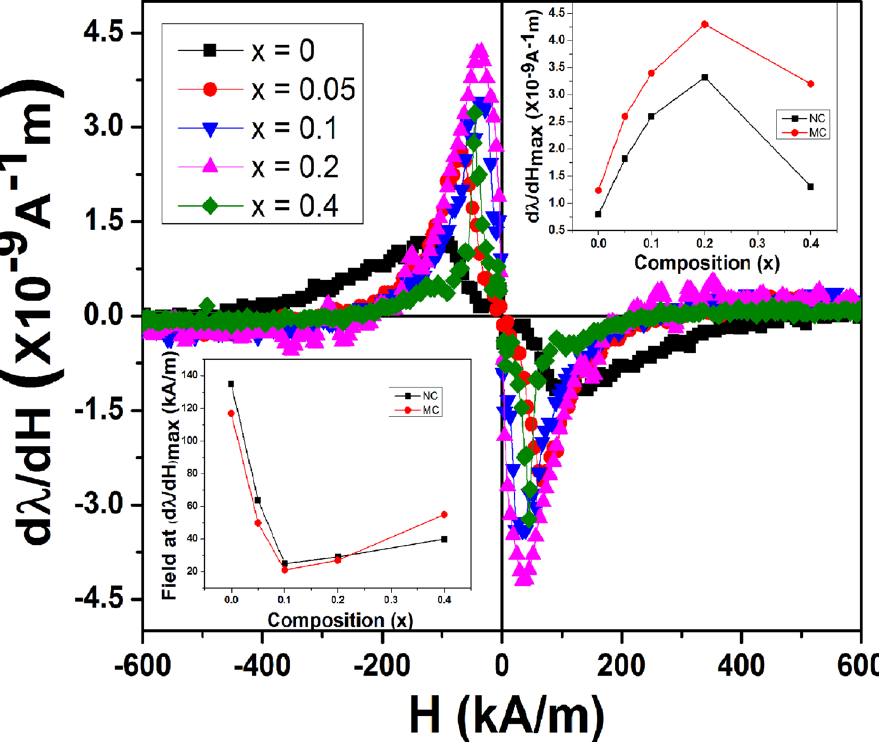
Figure 7. Magnetic field (H) dependence of strain derivative (d λ /dH) for Co 1 + x Zr x Fe 2 − 2x O 4 , (0 ≤ × ≤ 0.4)-MC samples. Inset: Variation of maximum strain derivative, (d λ /dH) max (Top right corner) and field (H) required to achieve that (lower left corner) as a function of composition